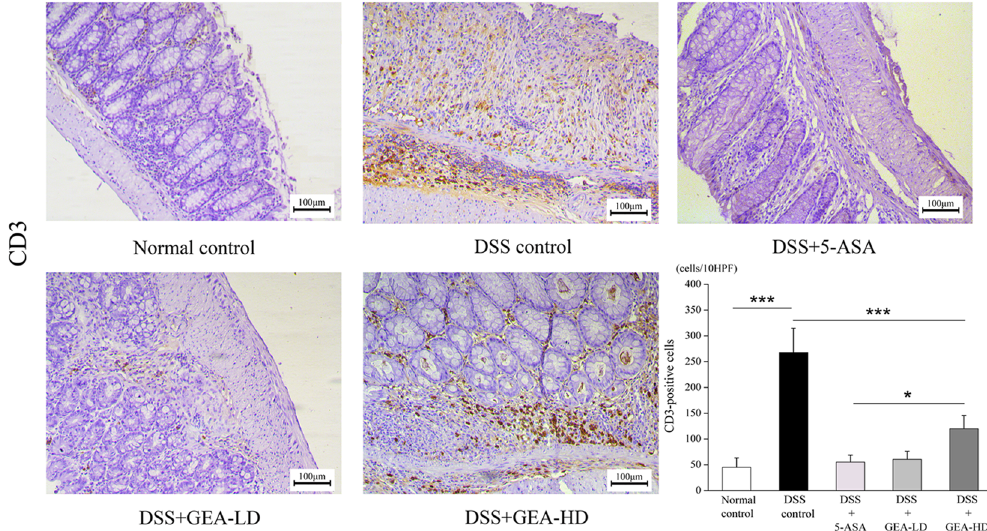
Figure 11. IHC for CD3 showed that the numbers of T-lymphocytes was significantly decreased in the GEA-LD and GEA-HD group compared with the DSS group. Meanwhile, the T-lymphocytes were higher in GEA-HD group compared with GEA-LD group. Scale bar = 100 μ m. The values are expressed as the